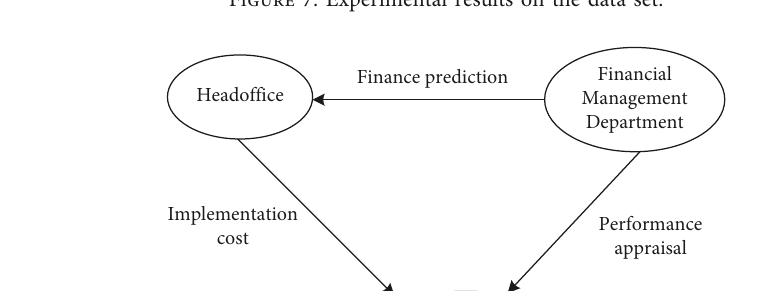
Figure 7: Experimental results on the data set.